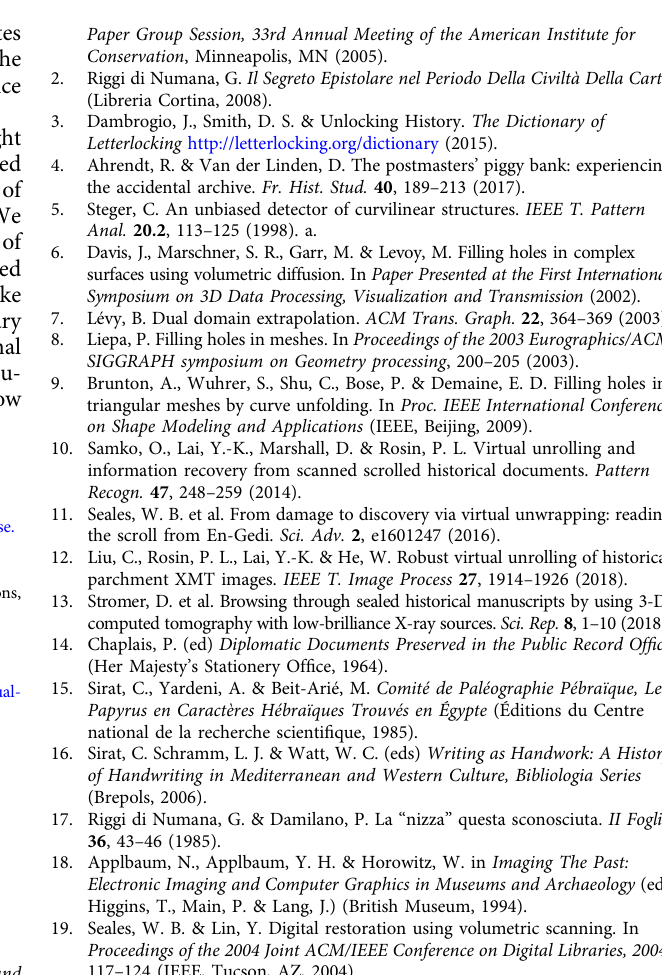
Fig. 8 Strain analysis of 2D embedding. Edge strain map (measured as edge length deviation in the 2D embedding as a percentage of nominal length in 3D embedding) for DB-1627 shows a nearly isometric mapping of the 3D embedding to a plane. Localized strain concentrated around creases (especially where creases intersect each other) and in other areas where poor initial segmentation leads to an accumulation of error during hybrid mesh propagation. Distortions of the 2D embedding can negatively impact automatic merging of connected components as demonstrated by: the large region a that was not successfully merged to the fi nal result; the region b that was incorrectly positioned in the fi nal result (should have been located at c ); and the region d containing text that was incorrectly positioned in the fi nal result. Scale bars: a , d 10